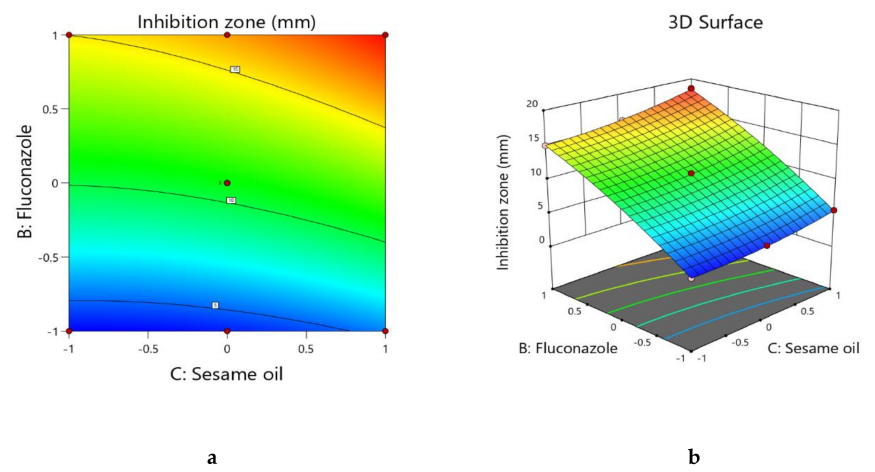
Figure 4. ( a ) Contour plot showing the interactions of sesame oil and fluconazole on the zone of inhibition of the FS-NTF. ( b ) Three-dimensional surface plot showing the interactions of sesame oil and fluconazole on the zone of inhibition of the FS-NTF.